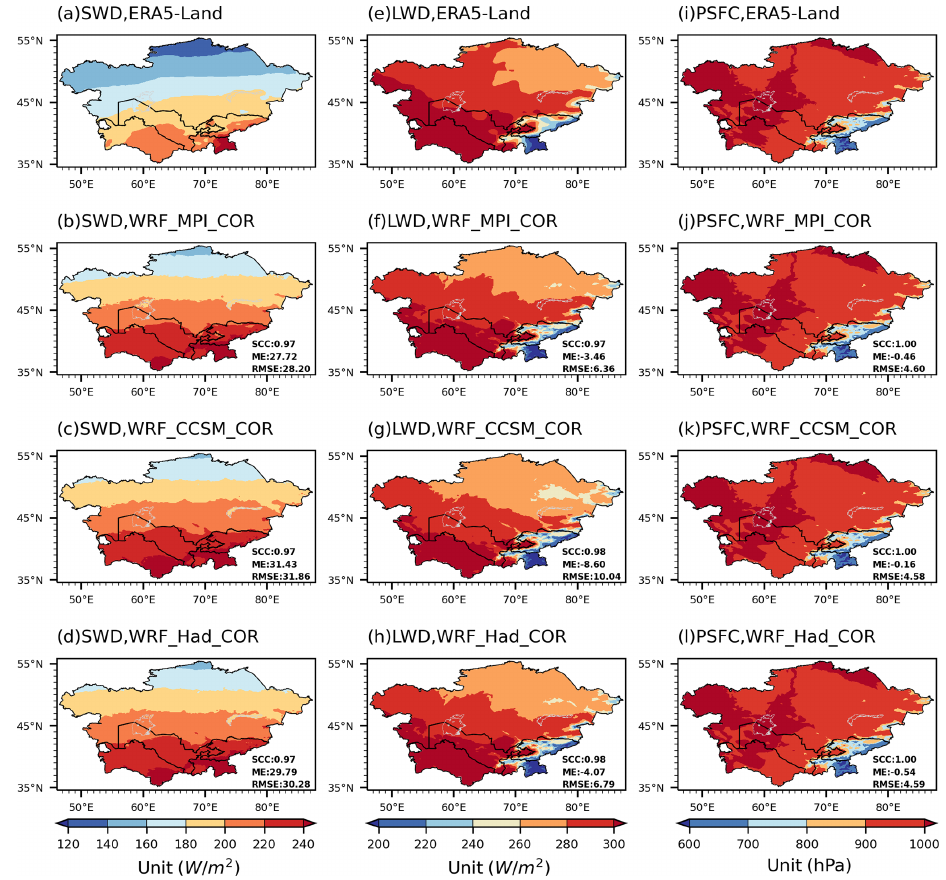
Figure 5. Same as Fig. 3, but for annual mean SWD, LWD, and